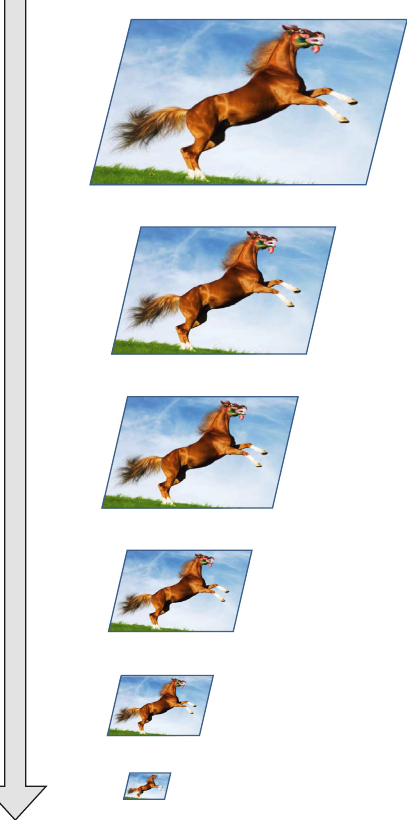
Figure 3: Pyramid of Gaussian difference